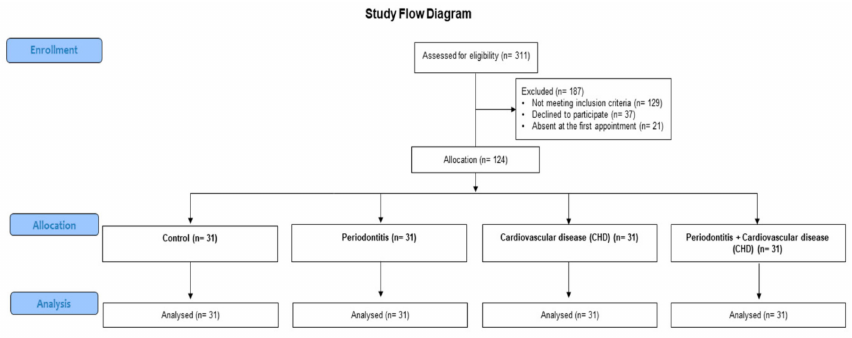
Figure 1. Flowchart of the